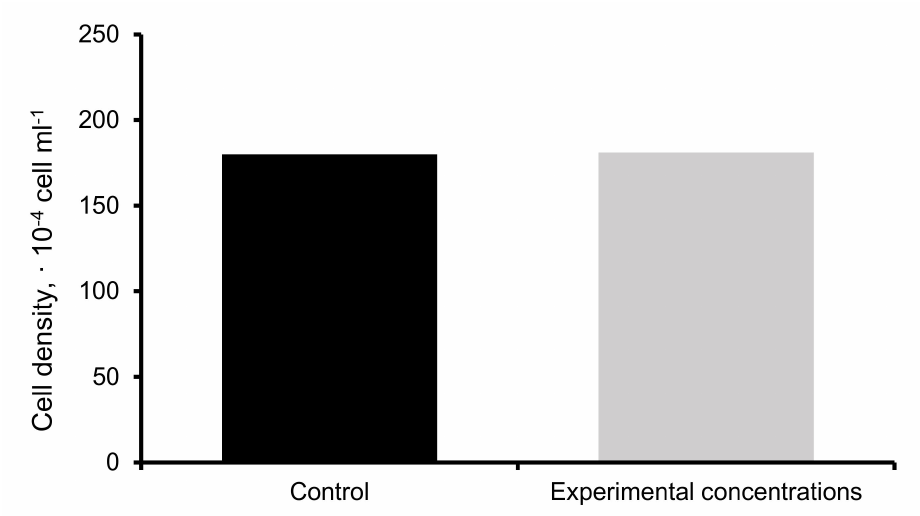
Figure 7. Average values of cell density of D. abundans M3456 in different treatment